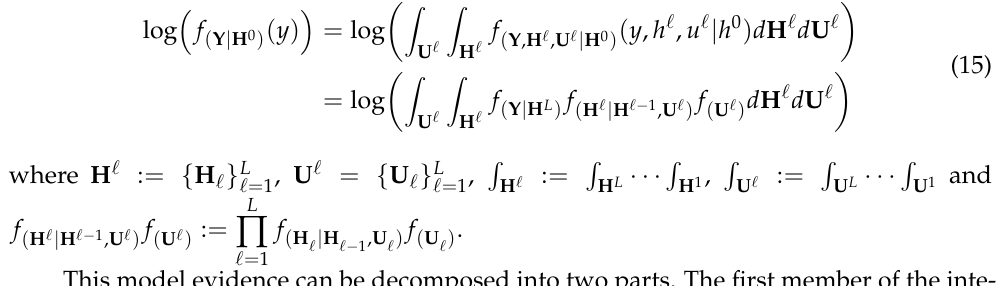
Figure 6. Structure of a DGP. Figure 5. Structure of a